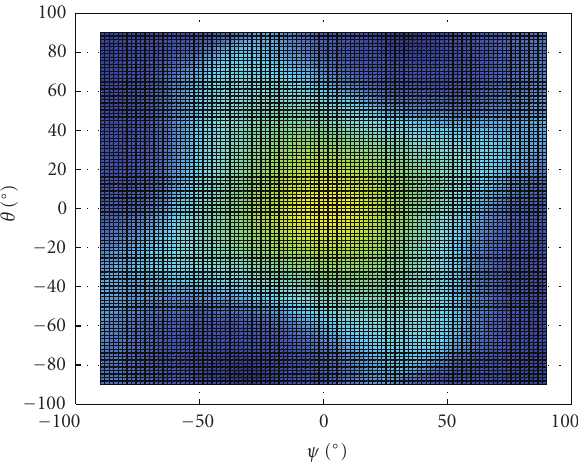
Figure 4: The dexterity of spherical mechanism from Figure 2.